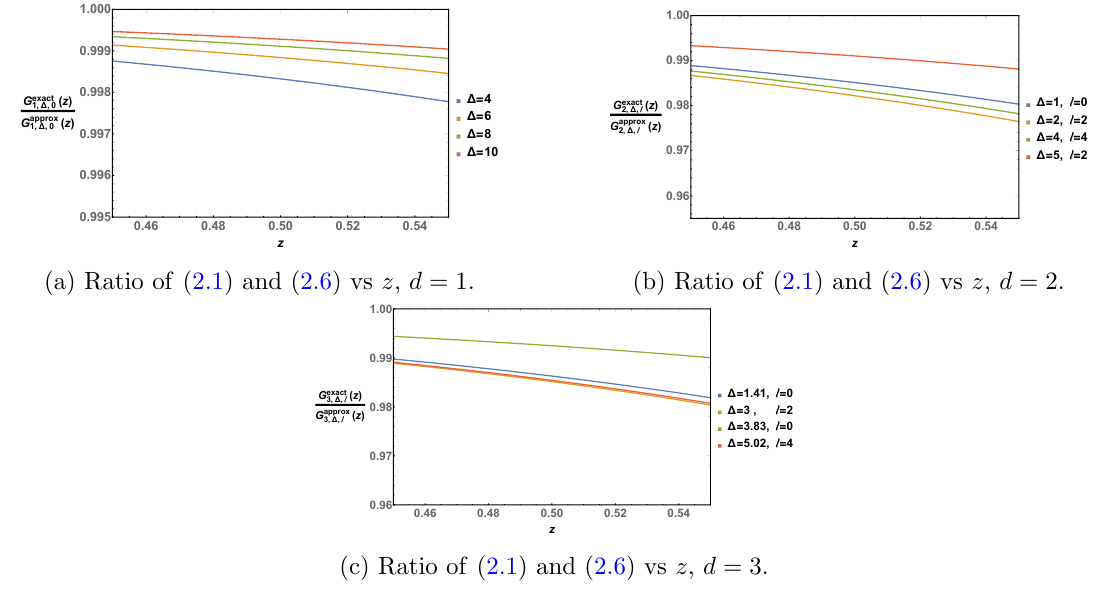
Figure 3. Ratio of (2.1) and (2.6) vs z for various (cid:1) and ‘ . As is clear eq. (2.6) gives an excellent approximation to the exact blocks for physical values of (cid:1) ; ‘ to within a few